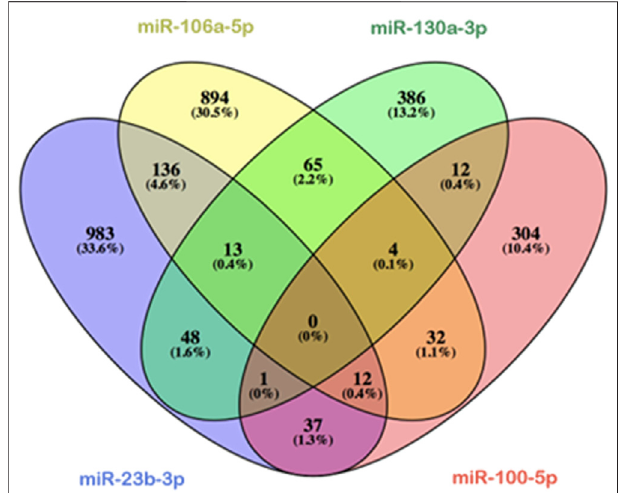
FIGURE 4 | Venn diagram shared potential targets of miR-23b-3p (blue ellipse), miR-130a-3p (green ellipse), miR-106-5p (yellow ellipse), and miR-100-5p(redellipse),studiedbymeansofmirWalksoftwareanalysis.Note insilico predictionsthatthefourmicroRNAsstudiedhavenotsharedany target, while a few numbers ofcommon targets are recognized bythree of the fourmicroRNAs.Overlappingellipsesrepresentsharedtargetsbetweenthese